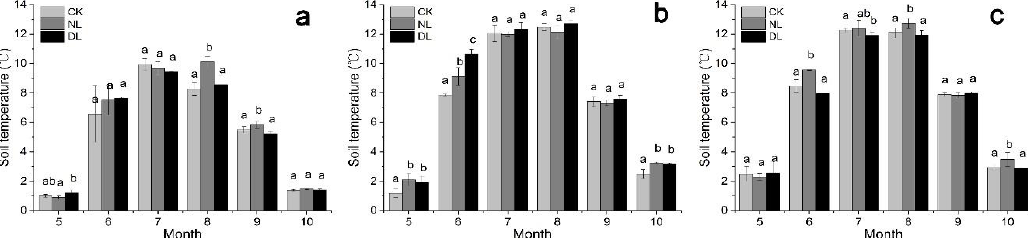
Figure 3. The monthly pattern of soil temperature (at 10 cm depth) under litter manipulation during the study period (May to October in 2018) in different-aged Betula platyphylla forests of the permafrost region, Northeast China. Stand ages included 25 ( a ), 40 ( b ) and 61 ( c ). Litter manipulation included NL (no-litter), DL (double litter) and CK (control litter) in each stand. Error bars indicate the standard deviation ( n = 9). Lowercase letters represent significant differences under the same month and varied litter manipulation ( p < 0.05).